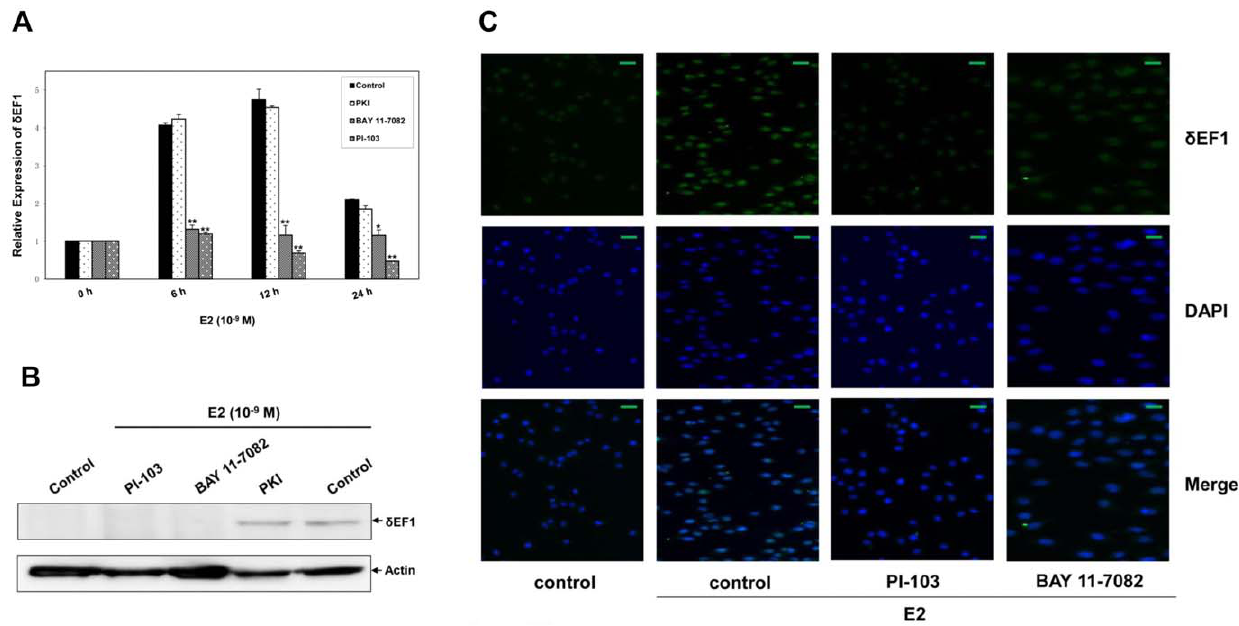
Figure 3. E2 treatment regulates d EF1 expression via PI3K and NF- k B pathways. A. MCF-7 cells were pre-incubated with PKI (5 m g/ m l), BAY 11-7082 (10 m M), or PI-103 (10 m M) for 0.5 h followed by treatment with 10 2 9 M E2. The expression of d EF1 mRNA was determined at the indicated time points following treatment using Q-PCR. GAPDH was used to normalize the d EF1 level. * indicates p , 0.05 in unpaired Student’s t-test compared with control. ** indicates p , 0.01 in unpaired Student’s t-test compared with control. The data represent three independent experiments. B. MCF-7 cells were pre-incubated with PKI, BAY 11-7082, or PI-103 for 0.5 h followed by treatment with 10 2 9 M E2. The expression of d EF1 protein was determined at 24 h following treatment using Western Blot. Actin was used to normalize the d EF1 level. C. MCF-7 cells were pre-incubated with PKI, BAY 11-7082, or PI-103 for 0.5 h followed by treatment with 10 2 9 M E2. The expression of d EF1 protein was determined at 24 h following treatment using immunofluorescence. Scale bars, 50 m